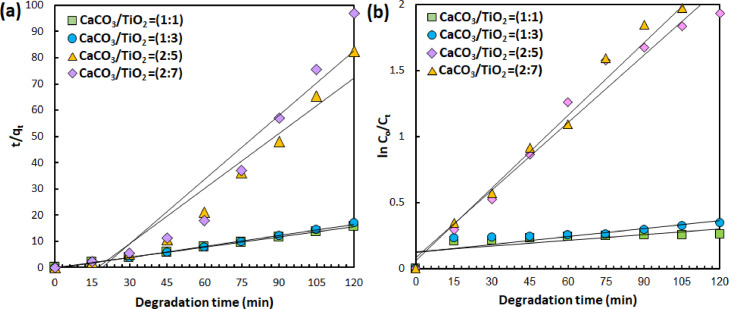
(a) Pseudo second order and (b) pseudo first order kinetic fit from photodegradation data of 10 ppm BG employing CaTiO3 prepared from different CaCO3/TiO2 composition.